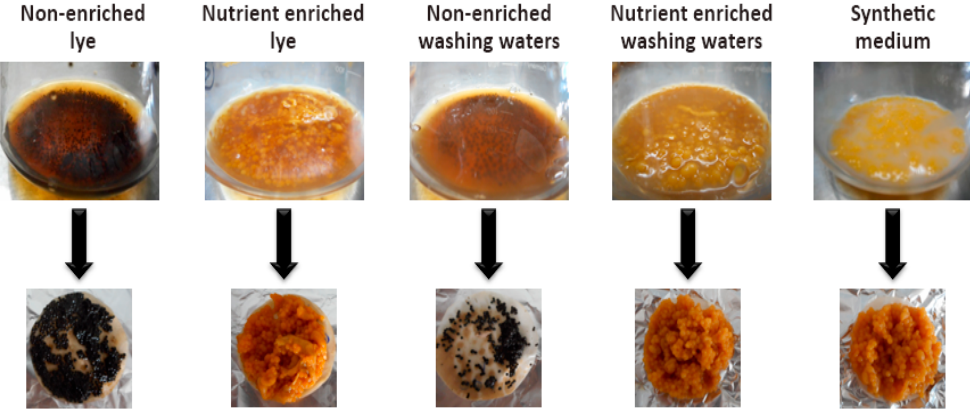
Figure A1. Macroscopic appearance of Blakeslea trispora in non-sterile lye and washing waters from Spanish-style green olive processing, without or after enrichment with nutrients, as well as in synthetic medium (fermentation time: 6 days).